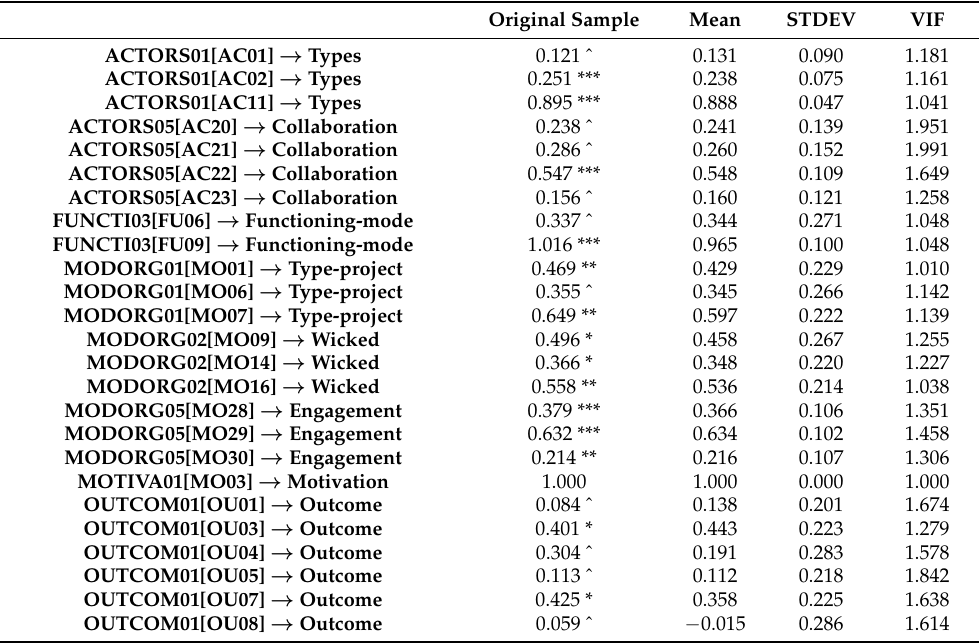
Table A4. Path coefficients, variance inflation factors (VIFs) of formative (Mode B) criteria and their 25